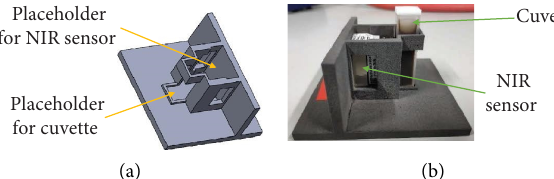
Figure 2: Te design scheme of the fxture (a) and the real-life application (b).